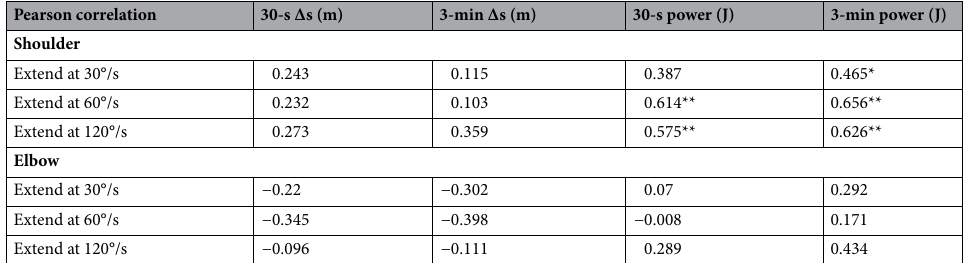
Table 2. Correlations between upper limb isokinetic muscle strength and subject performance (subject ∆ s and output power in 30-s and 3-min). Statistical significance is represented by **, P < 0.01, *, P < 0.05. ∆ s distance of a poling phase during double